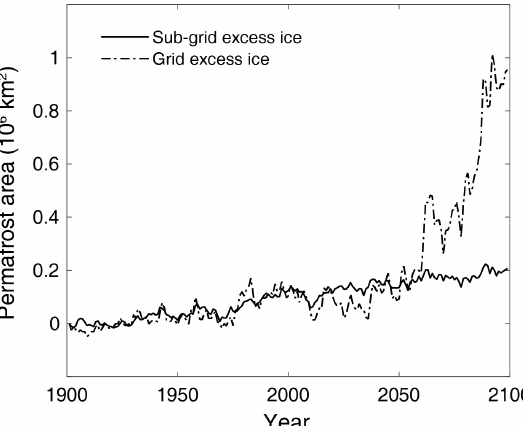
Figure 9. Difference in modeled permafrost area versus time be- tween the sub-grid ice case and no-ice case, as well as between the grid-average ice case and no-ice